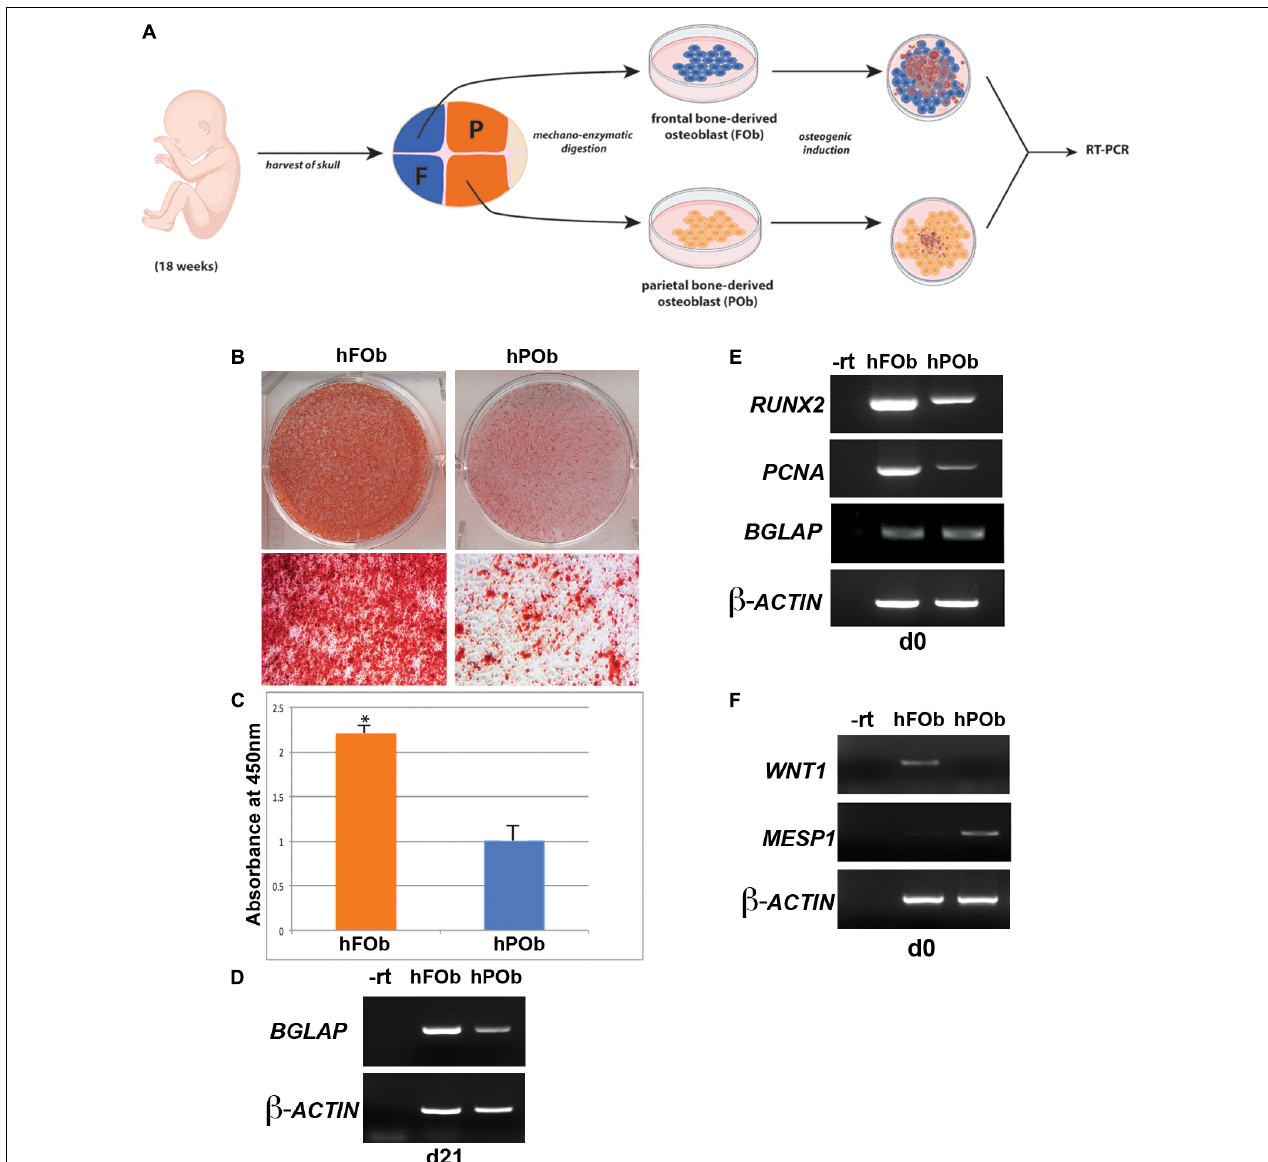
FIGURE 1 | Differential osteogenic potential is hallmark of hFOb and POb. (A) Schematic representation of the experimental procedures. Abbreviations: F, Frontal bone; P, Parietal bone. (B) In vitro osteogenic differentiation of hFOb and hPOb prepared from fetal (18-weeks) human frontal and parietal bone. Alizarin red staining performed at day 21 of the osteo-induction assay showed a more robust mineralization of the extracellular matrix (ECM) in hFOb as compared to hPOb. (C) Quantification of Alizarin red staining further confirmed a more abundant mineralization of the ECM in hFOb, * p -value < 0.05 (D) RT-PCR expression analysis of the late marker of osteogenesis, BGLAP ( OSTEOCALCIN ) revealed higher expression of this gene in hFOb then hPOb (at day 21), thus suggesting a more advanced terminal osteogenic differentiation of hFOb relatively to hPOb. (E) RT-PCR expression analysis of the osteoprogenitors marker RUNX2 at day 0, prior osteo-induction assay showed a major increase in the expression of this gene in hFOb than hPOb, thus indicating the presence of a larger pool of osteoprogenitors in hFOb. Elevated levels of PCNA paralleled the increased expression of RUNX2 in hFOb as well, suggesting a higher proliferative activity of hFOb as compared to hPOb. Conversely, no differences in the expression levels of BGLAP were observed between the two types of osteoblasts. (F) RT-PCR expression analysis showing unique expression of the neural crest marker WNT1 in hFOb but not in hPOb, whereas expression of the mesoderm marker MESP1 is observed only in hPOb.